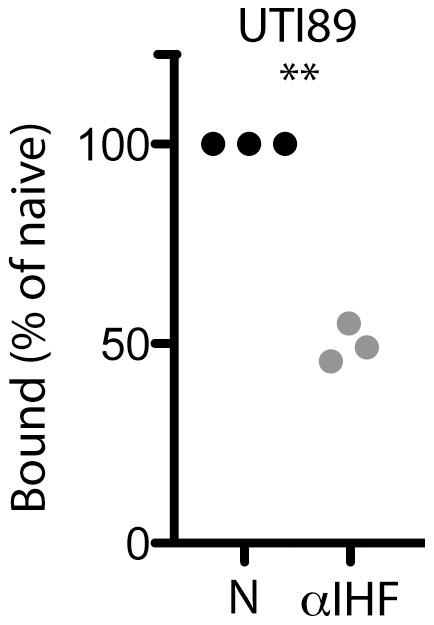
Antiserum against IhfAB reduces UPEC binding to cultured bladder epithelial cells.HTB-4 human bladder transitional carcinoma cell monolayers were infected with UTI89 treated with naïve antiserum (N; black) or specific antiserum directed against IhfAB (αIHF; gray). Each symbol represents the average of three experiments performed on the same day. Each experiment was replicated on three separate occasions. The number of bacteria bound is reported as a percentage of the bacteria bound in the presence of naïve serum. Statistical significance was determined by two-tailed Mann-Whitney test (**, p = 0.003).